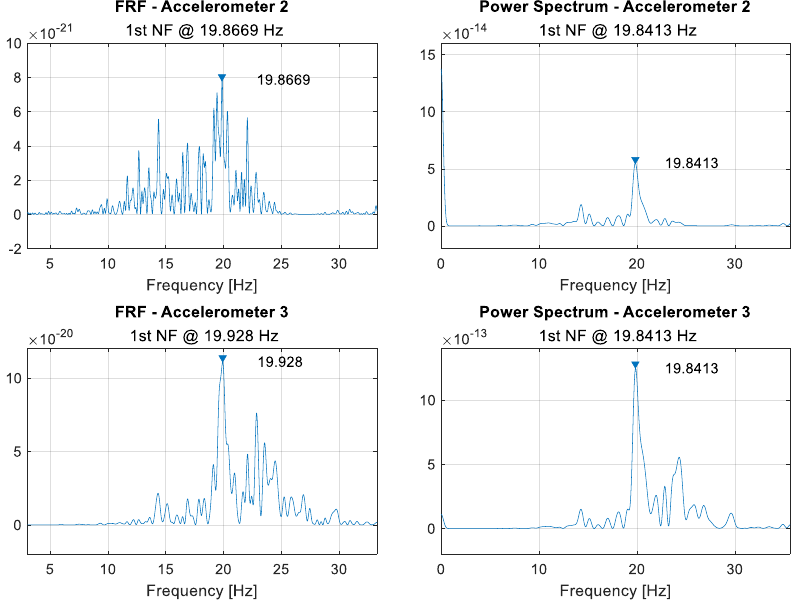
Figure A6. A close-up of FRF and the power spectrum plot. The peaks are at 19.928 Hz and 22.88 Hz for the FRF and 19.8 Hz and 24.23 Hz for the power spectrum, respectively.